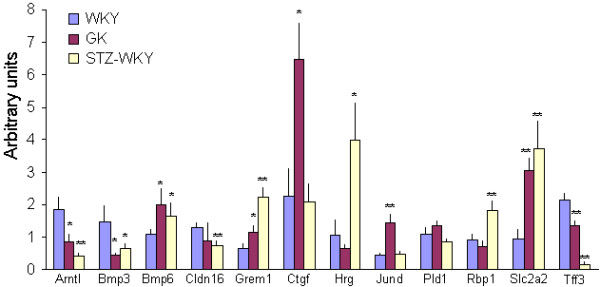
Validation of microarray results by quantitative real time PCR. The expression of 12 selected genes was assessed by QRT-PCR in kidney samples of GK, STZ-WKY and WKY rats previously used for microarray-based transcription profiling. Results are expressed as means ± SE, in percentage of normalized WKY values. *P < 0.05, **P < 0.01 statistically significantly different to WKY controls.